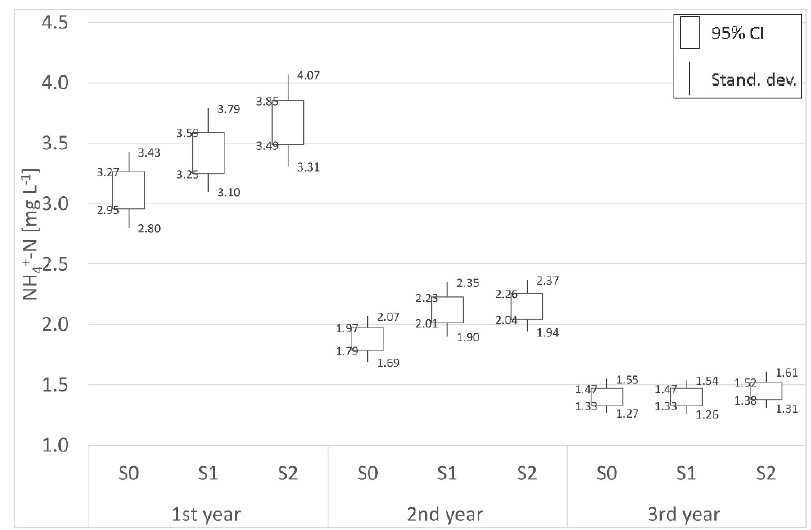
Figure 11. The concentrations of NH 4+ -N in groundwater under shelterbelt soils.